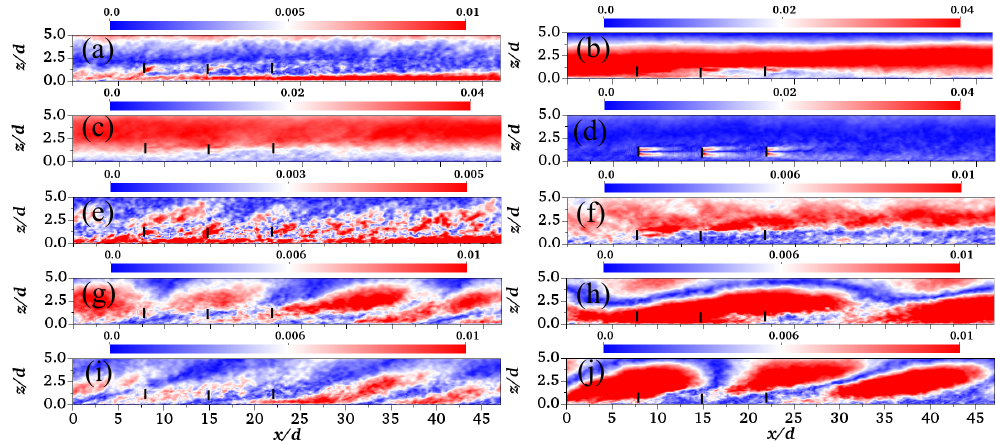
Figure 7. Normalized POD mode for ( a ) m = 0, ( b ) m = 1, ( c ) m = 2, ( d ) m = 3, ( e ) m = 4, ( f ) m = 5, ( g ) m = 6, ( h ) m = 7, ( i ) m = 8, ( j ) m = 9. Red-blue contours indicate the normalized velocity ϕ u m √ λ m / U ∞ magnitude modes, . Thick black vertical lines–turbine | |